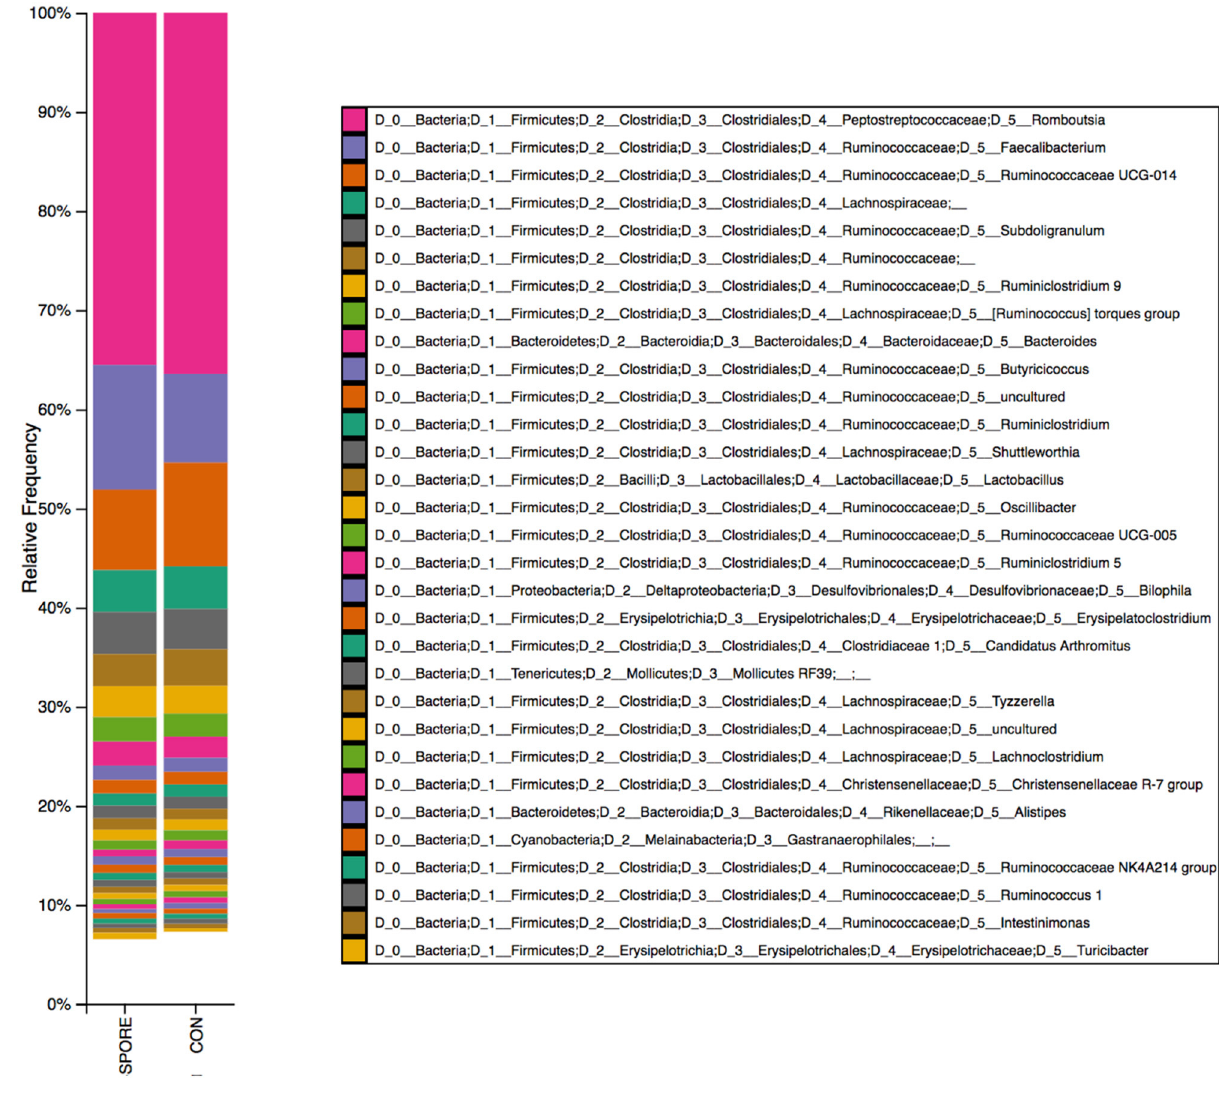
Several immune and metabolic signaling pathways were dramatically altered by SFB treatment. The top 19 immunologic and 18 metabolic altered pathways are shown in Tables 2 , 3